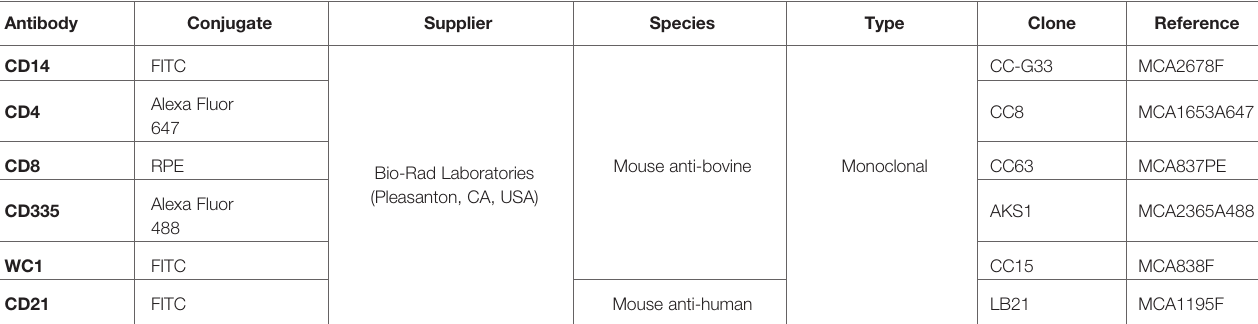
TABLE 1 | List of antibodies used for analysis of cell subsets in PBMC, ileofemoral lymph node, fetal thymus and spleen. Antibody